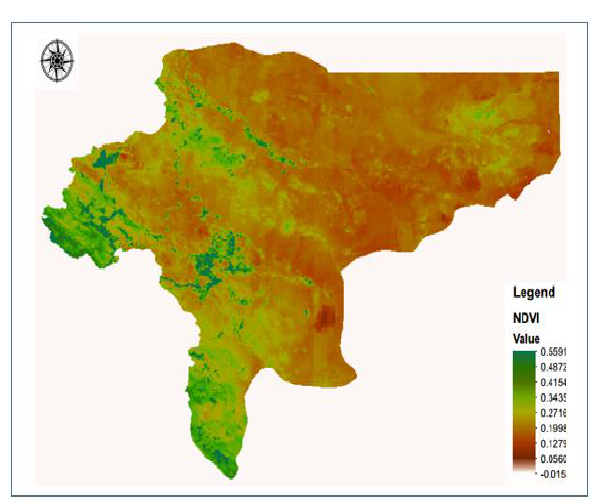
Figure4. NDVI index modelled by ANN in July 2018